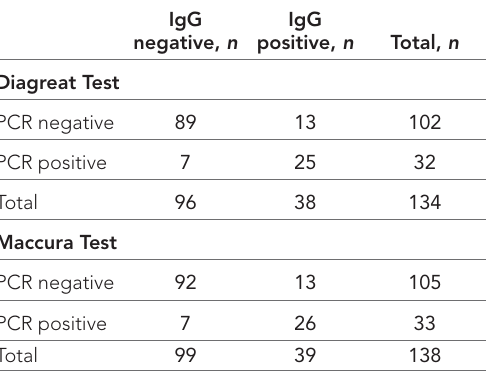
Table 4 Relationship between Diagreat and Maccura IgG test results and previously